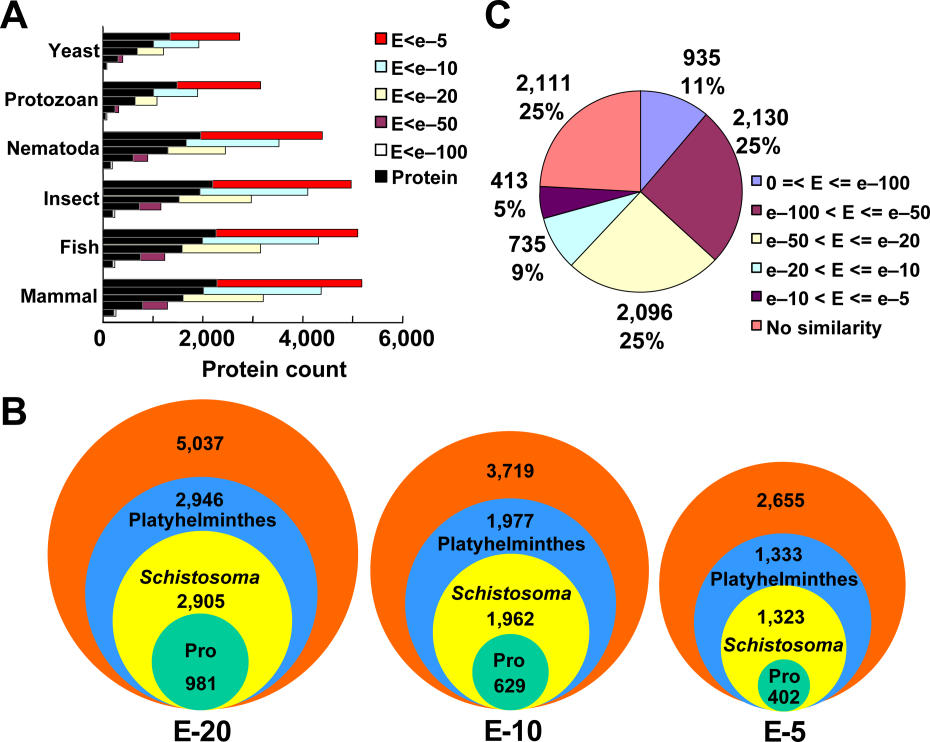
Comparative Genomic Analysis of S. japonicum Genes with CDSs from Representative Sequenced Genomes(A) The deduced S. japonicum proteins were compared with public protein datasets from mammalian hosts (Homo sapiens, R. norvegicus, and M. musculus), fish (T. nigroviridis and T. rubripes), insects (A. gambiae and D. melanogaster), nematodes (C. briggsae and C. elegans), protozoans (P. yoelii nigeriensis [17XNL], P. falciparum [3D7]), (Cryptosporidium parvum and C. hominis), and fungi (S. cerevisiae) at a cutoff of different BLASTP E values indicated by icons. The black bars indicated that the numbers of the deduced protein were identified by this proteomic analyses.(B) Potential Phylum Platyhelminthes- and Schistosoma-specific genes were predicted through interrogating the platyhelminth and Schistosoma ESTs in GenBank. The numbers within the largest (orange) circle indicate S. japonicum CDSs that were not similar to any known protein in a GenBank dataset, which excluded all flatworm sequences at a cutoff of different BLASTP E values. The numbers within the middle-sized blue and small yellow circles represent S. japonicum CDSs with similarity to the EST data from platyhelminths and schistosomes, respectively, at a cutoff of tBLASTN E value of 10−20. The numbers within the smallest green circles indicate proteins identified by the proteomic approach.(C) S. japonicum CDSs were compared with EST and cluster datasets of S. mansoni using the tBLASTN program at a cutoff of different E values indicated.